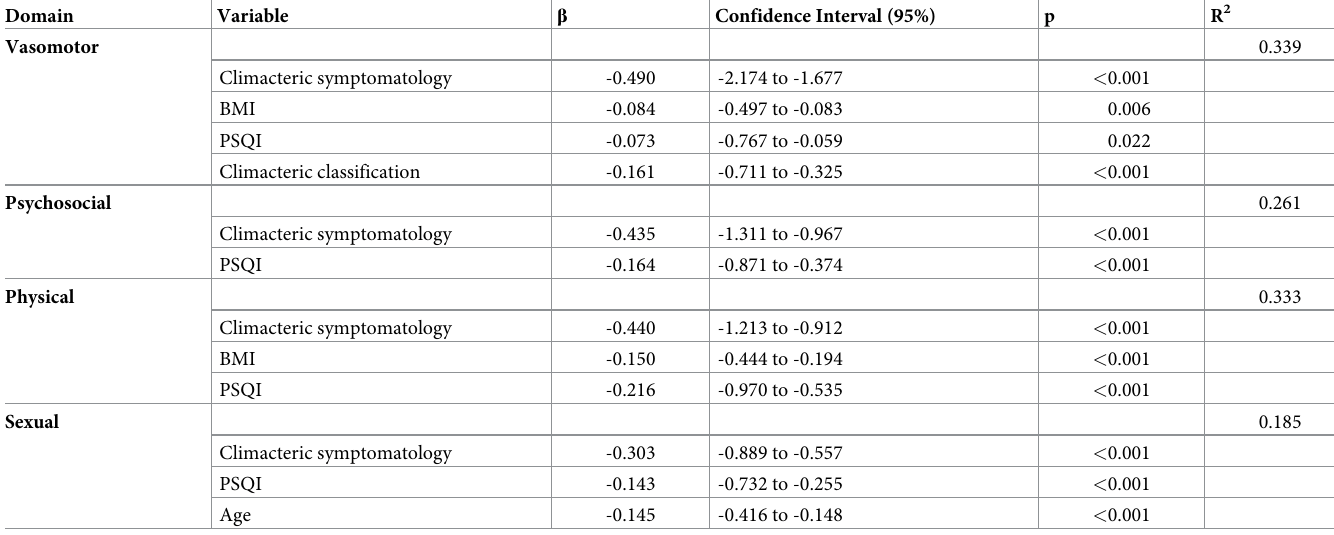
Table 5. Linear regression according to the demographic and socioeconomic variables, life habits, and health care of climacteric women in relation to the MENQOL domains,